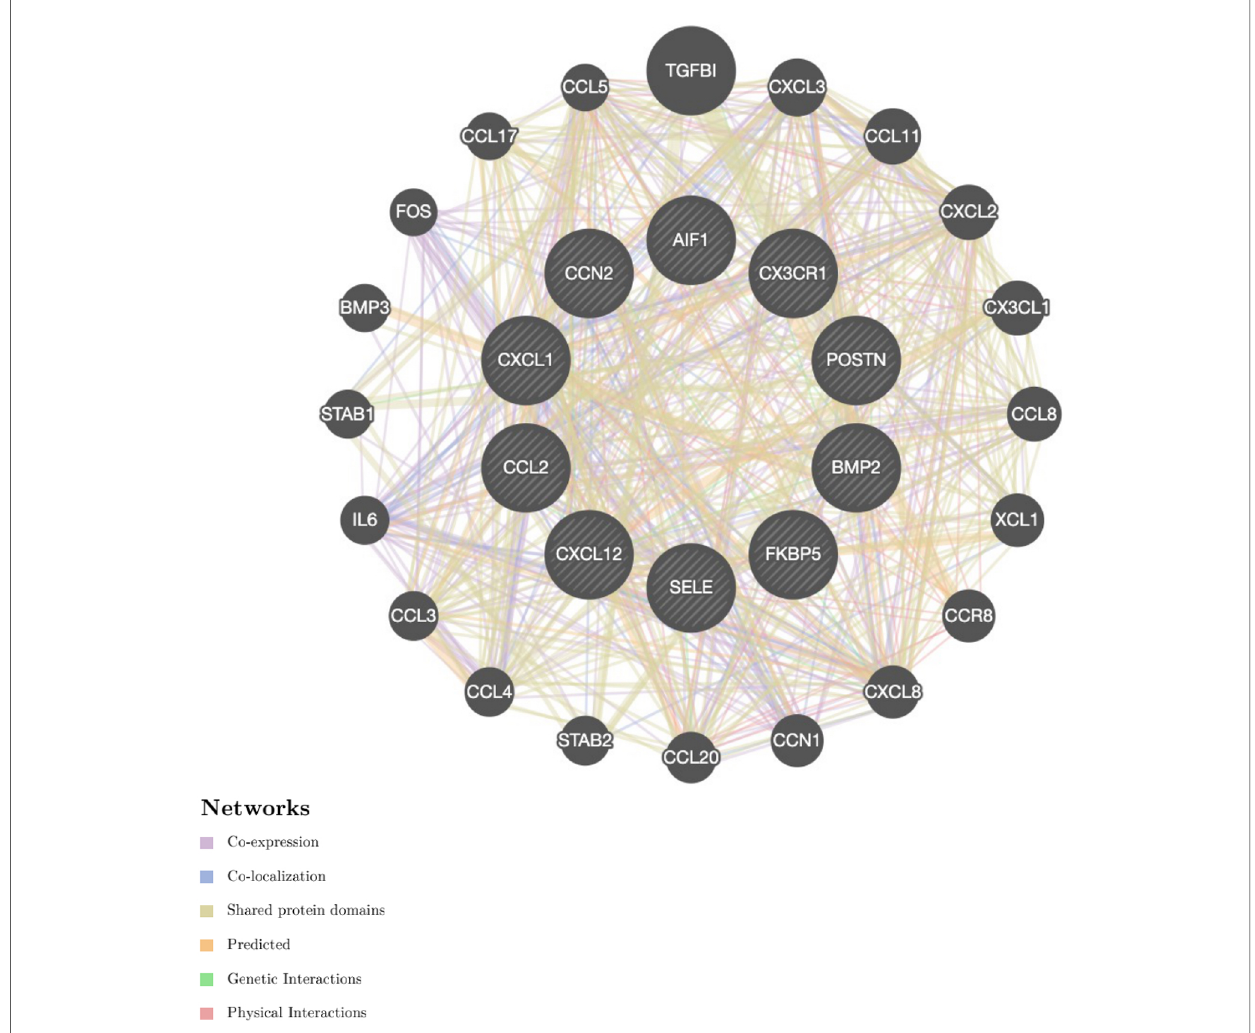
FIGURE 7 Protein – protein interaction network of the top 10 hub genes. Inner circles represent the hub genes, and outer circles correspond to GeneMANIA- proposed hub genes.